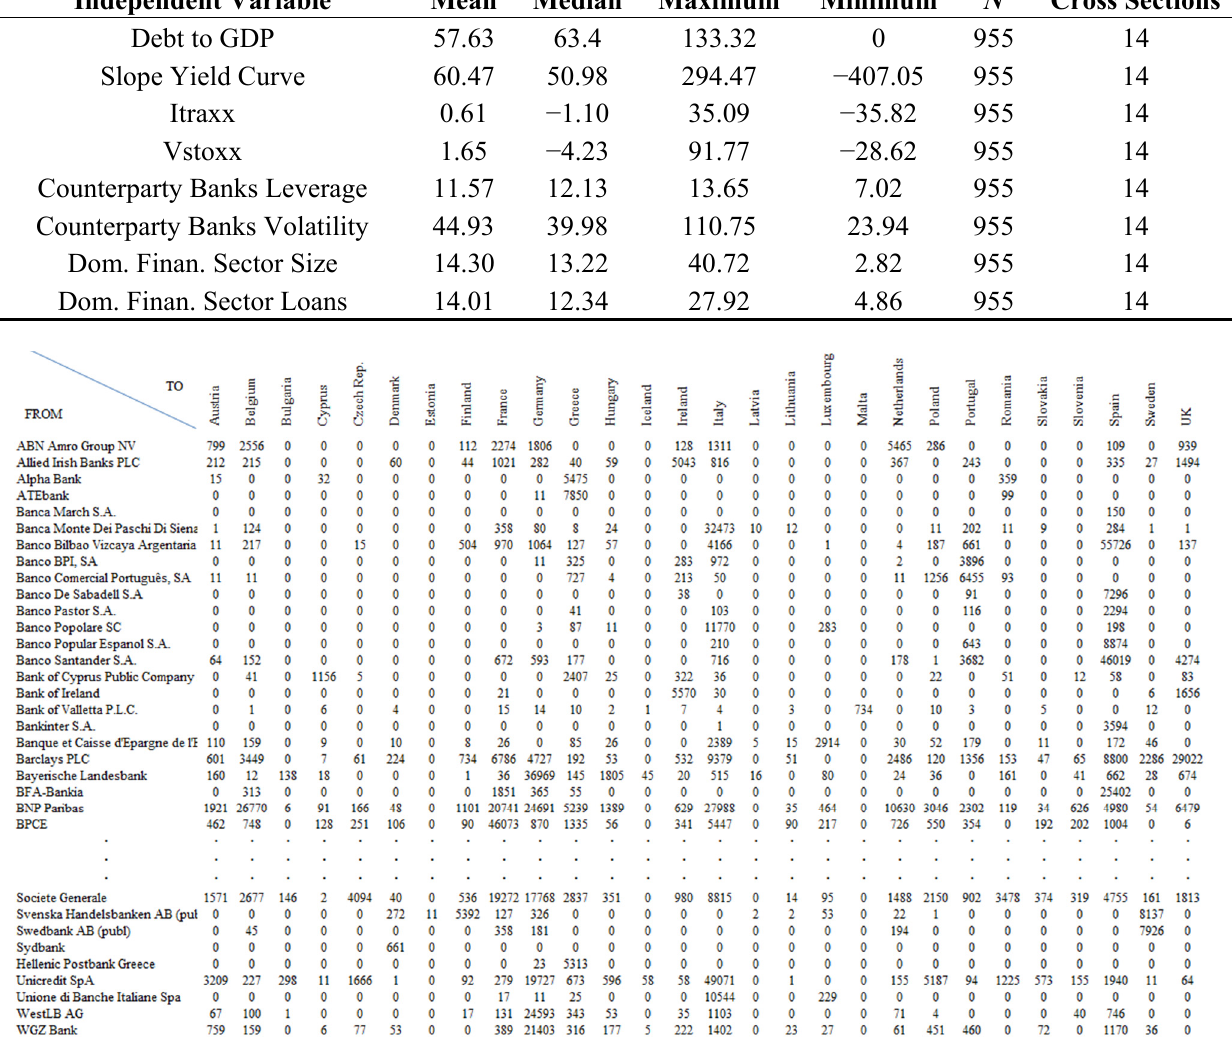
Figure A1. Partial Network Matrix December 2010. Data obtained from EBA, figure created by author. Due to the extent of the matrix, it is shown here only partially. The matrix shows the links going from banks to sovereigns. Values in millions of